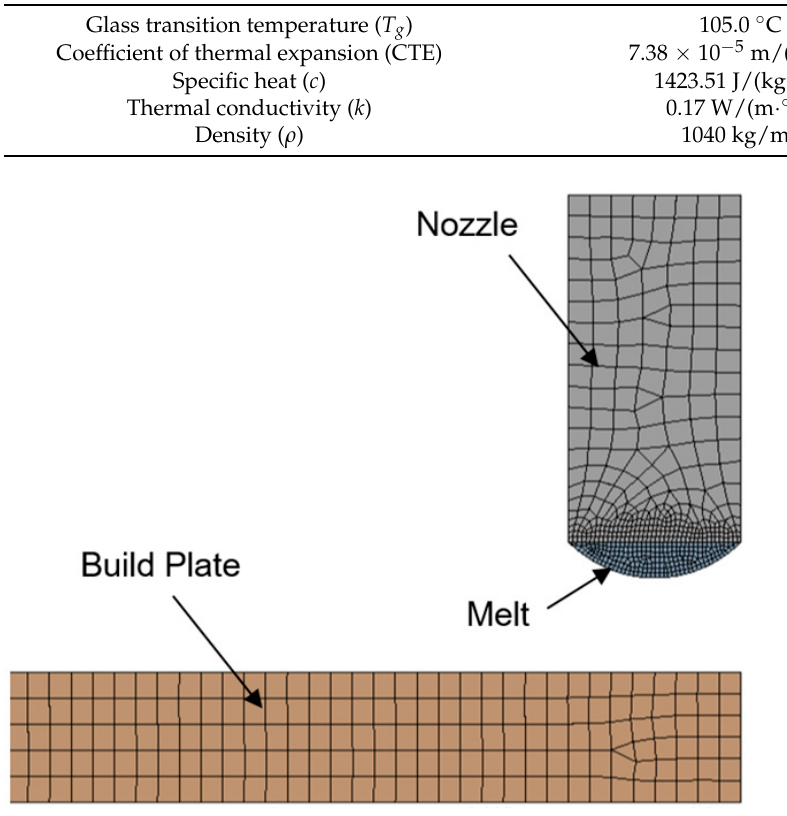
Figure 6. Initial element size distribution of the build plate, the nozzle, and the melt.